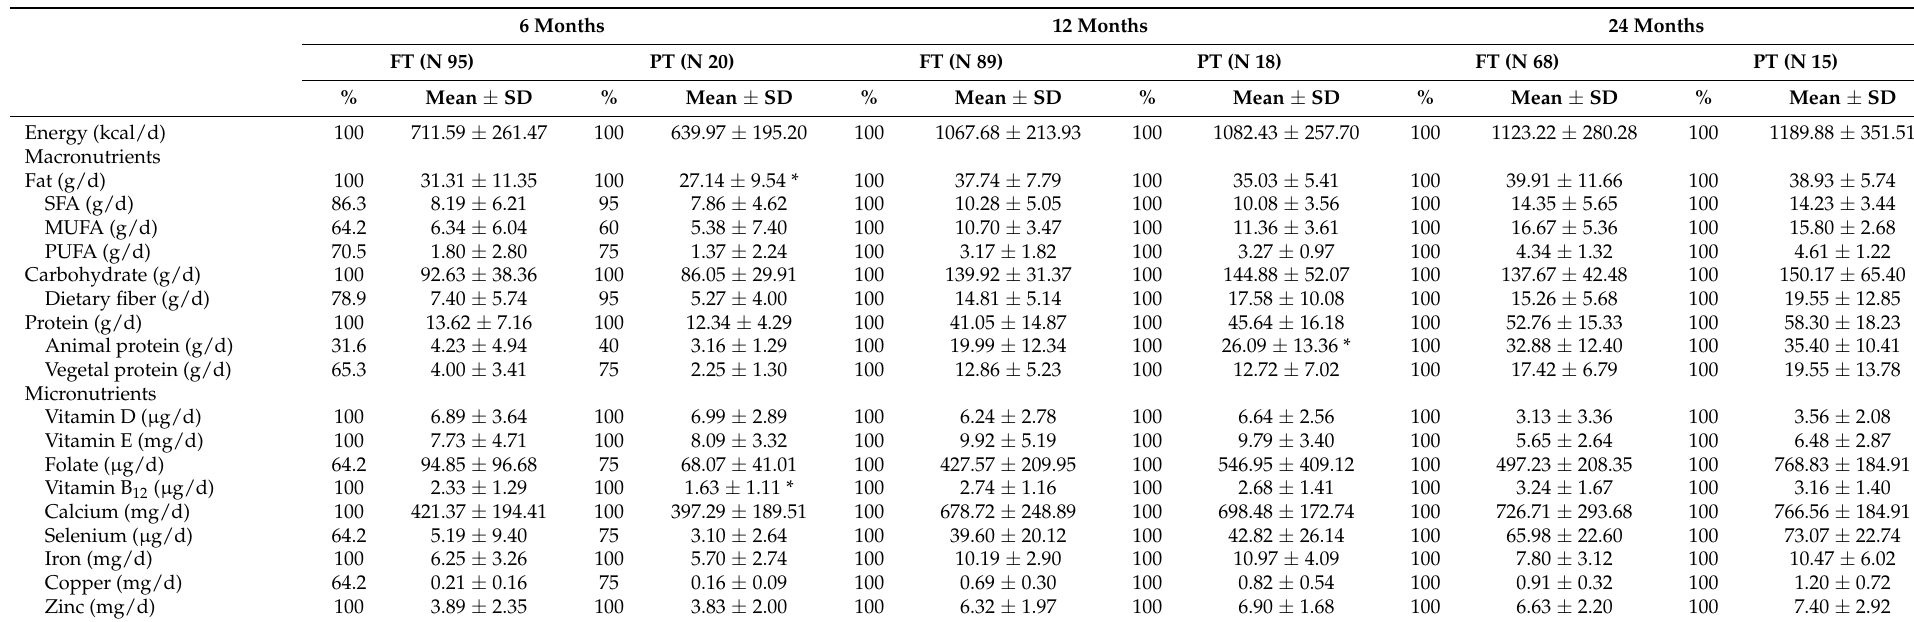
Table 3. Differences in the nutritional intake between Full-term (FT) and Preterm (PT) toddlers from 6 to 24